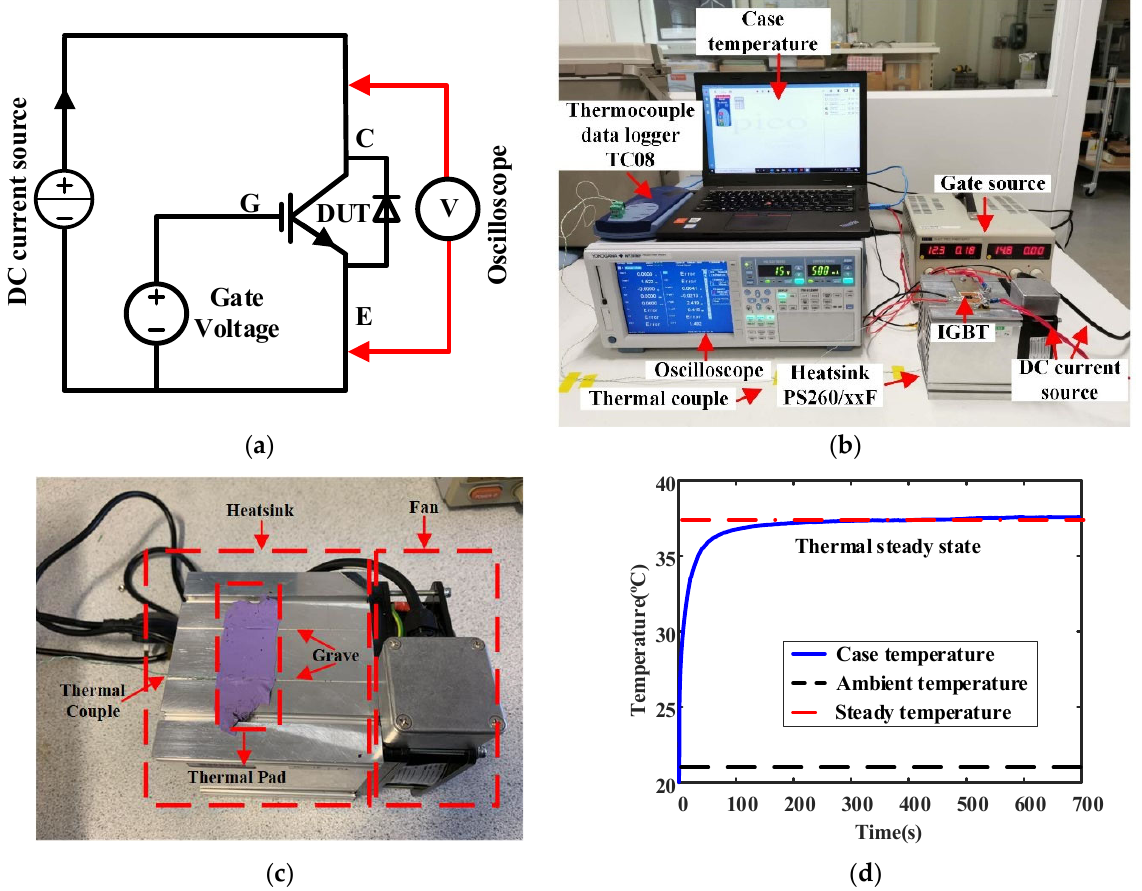
Figure 12. Test bench: ( a ) main electrical circuit; ( b ) test environment; ( c ) thermal couples on heatsink; ( d ) temperature curve of case point on heatsink at 30 A.